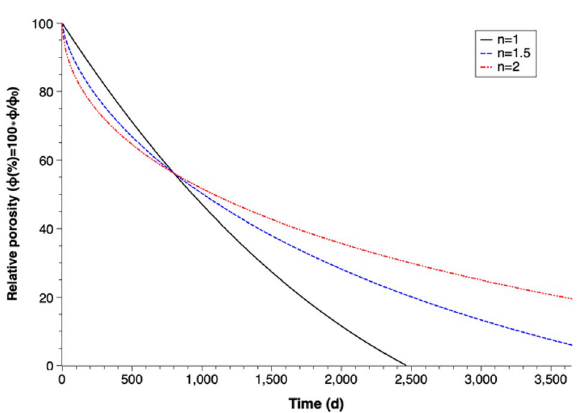
Figure 4. Percentage decrease of relative porosity through the formation of goethite over time for different coefficients of passivation